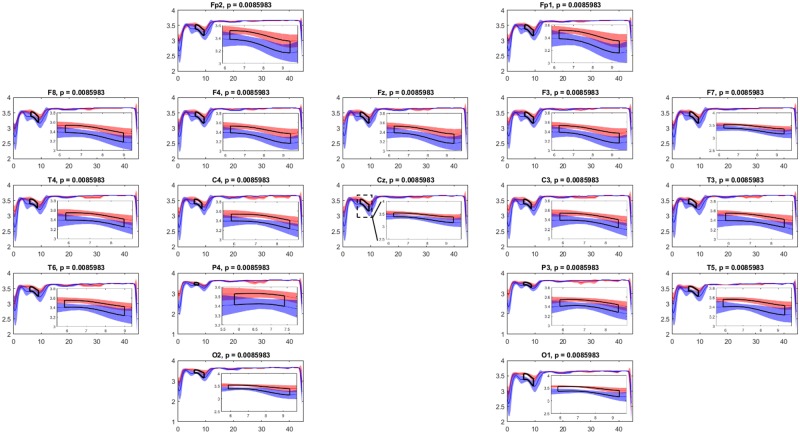
Result of the permutation test.Mean and confidence interval of the LSE for epileptic patients group 1 and group 2 in red and blue respectively. Interval of statistical significance in black. We show zoomed windows of significant frequencies overlapping the entire spectral range at each electrode. There exists significance in all channels at p = 0.0086 at least in the range of frequencies [6.25–12.89)Hz.